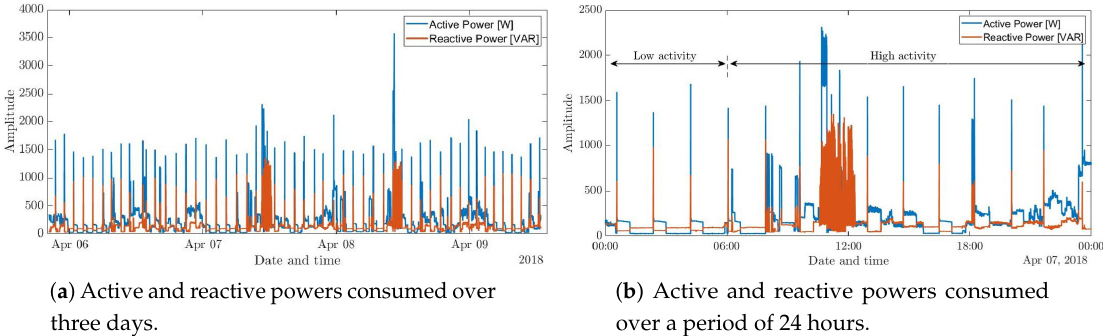
Figure 12. Snippets of electric power consumption acquired by the single-phase system in a residential setting over a period of seven days.